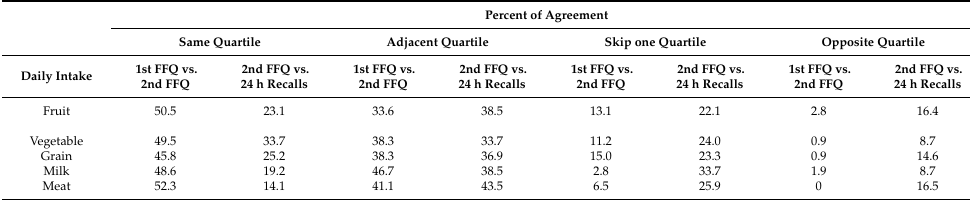
Table 5. Agreement in quartile distribution of food groups intake between two FFQ surveys and 24 h recall.